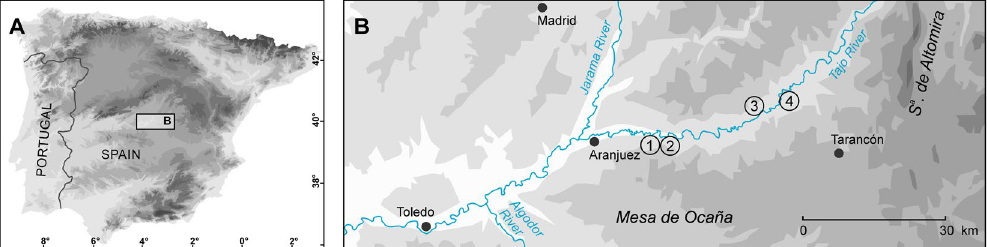
Figure 1. Maps showing ( A ) the location of the Tagus loess record in central Spain and ( B ) the position of the loess sections mentioned in the text: 1 Section Paraíso; 2 Section Villarubia; 3 Section Fuentidueña; 4 Section A3. The map was generated using ArcGIS 10.2.2